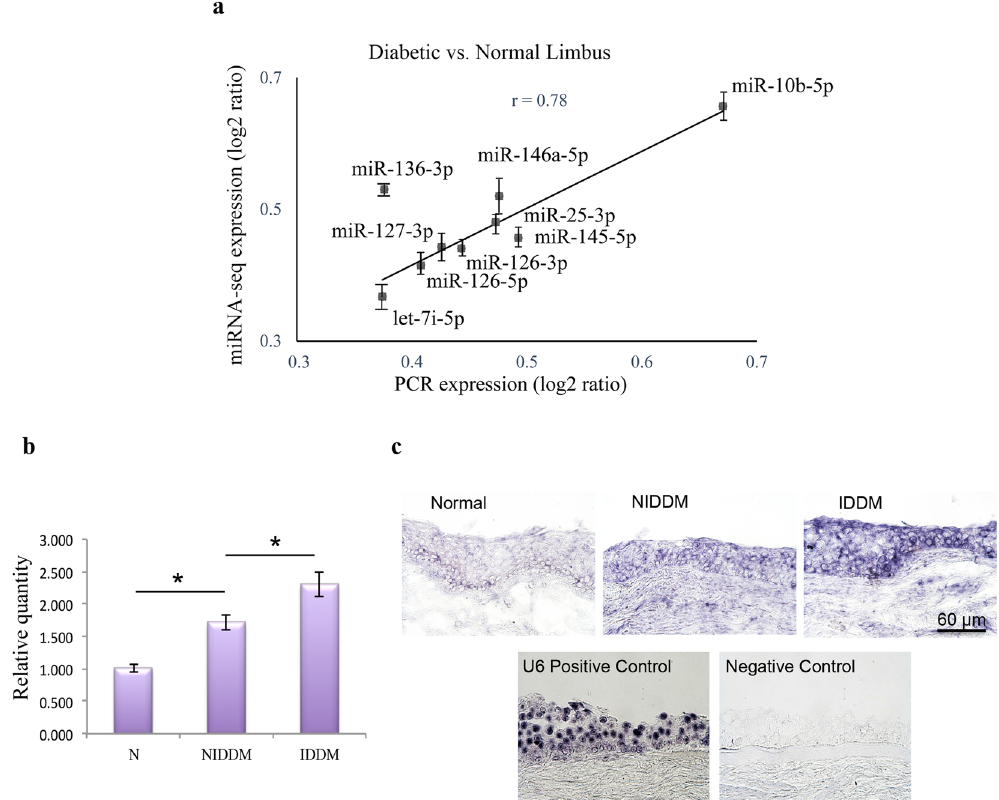
Figure 4. Validation of deep sequencing data of differentially expressed miRNAs in diabetic vs. normal limbus. ( a ) QRT-PCR validation of deep sequencing data, diabetic vs. normal limbus. Several miRNAs are indeed differentially expressed in diabetic vs. normal limbus. The results are in good agreement with deep sequencing analysis (correlation r = 0.78). ( b ) QRT-PCR validation of deep sequencing shows that miR-10b is expressed significantly more in T1DM (IDDM) than in T2DM limbus and more in T2DM (NIDDM) than in normal limbus. ( c ) miR-10b, in situ hybridization with LNA modified probes was performed on sections of normal and both T1DM (IDDM) and T2DM (NIDDM) corneas, compared to scrambled sequences. The miRNA signals are stronger in the T1DM than in T2DM limbus and the signals are stronger in T2DM than normal limbus, corroborating our QRT-PCR and deep sequencing data. U6 miRNA probe and scrambled sequences were used as positive and negative controls, respectively. Bar = 60 μ